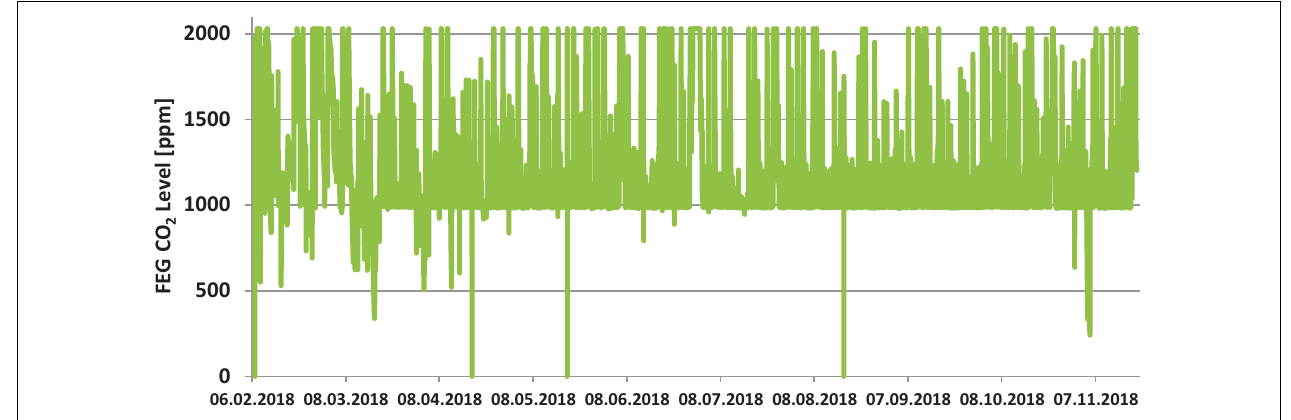
Time FIGURE 6 | FEG atmospheric CO 2 level during the experiment phase (one data point per minute). Note that the sensor used had an upper limit of 2000 ppm. This value was exceeded frequently due to the presence of the on-site operator. TABLE 3 | Lettuce edible fresh weight production values. Edible fresh Time normalized Edible fresh Average weight per edible fresh weight weight per Cycles for cultivation cultivation area per cultivation area cultivation